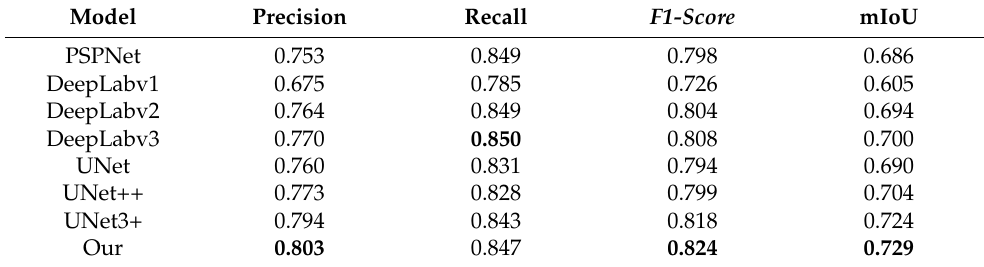
Table 4. Performance metrics for each